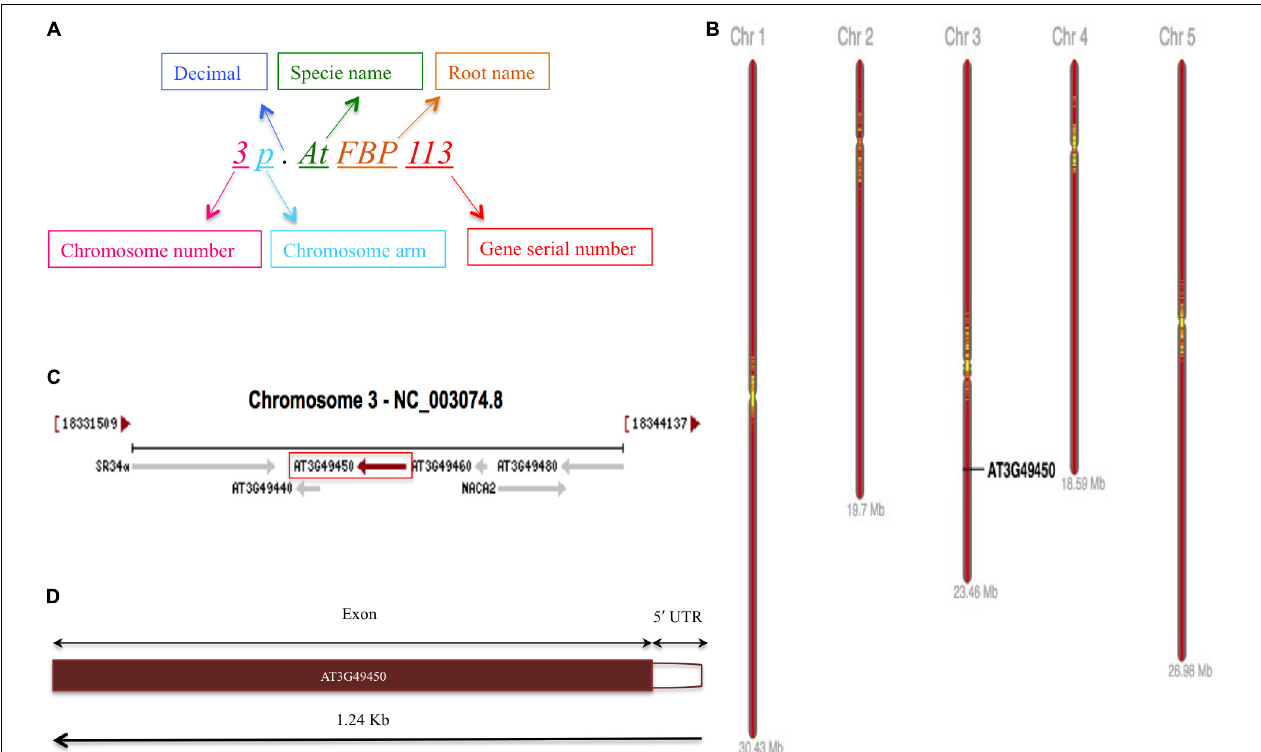
Table S1 . The ePlant chromosome viewer used for determining